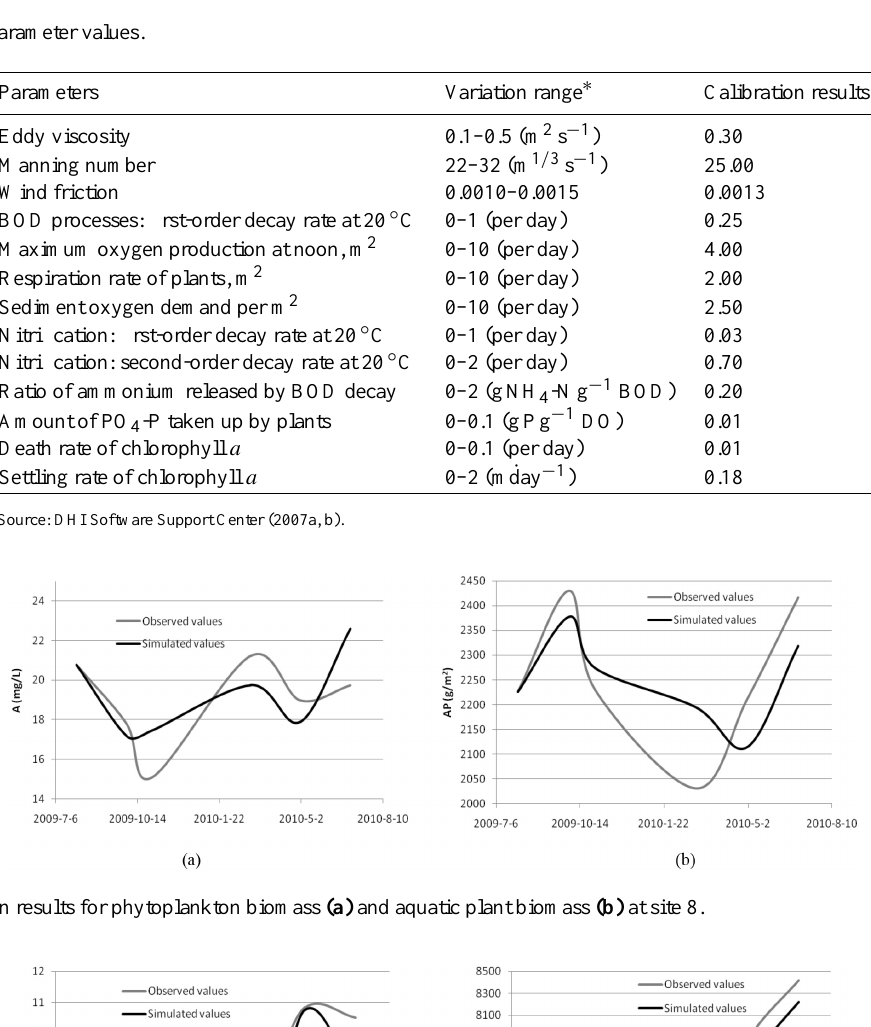
dissolved inorganic phosphorus (DIP). Conversion